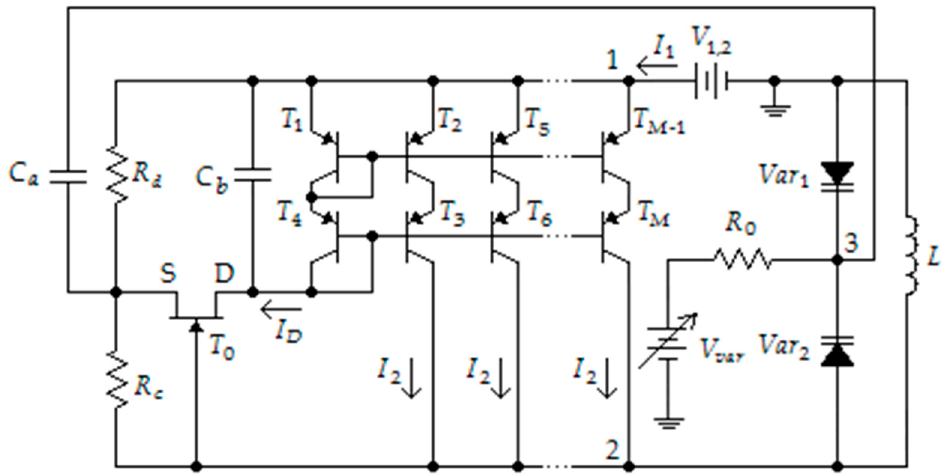
Figure 9. Voltage-controlled oscillator with multiple-output cascode current mirror.